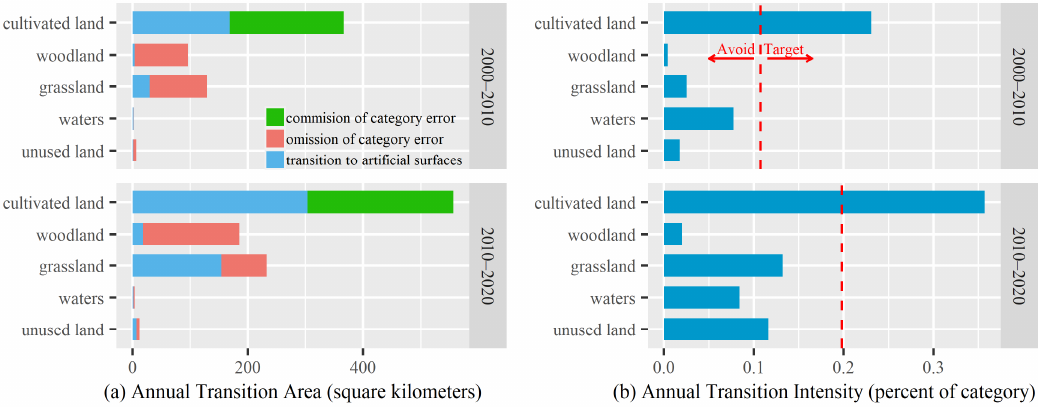
Figure 14. Intensity analysis for transition to artificial surfaces for the middle reaches. The transition size along with hypothetical map errors ( a ); transition intensities ( b ). The red, vertical dashed lines indicate the uniform intensities.